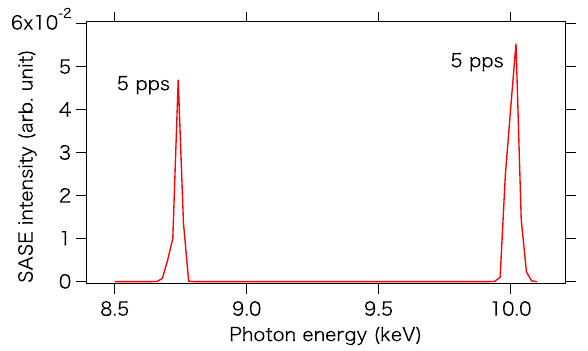
FIG. 5. Spectra of SASE measured by scanning a mono- chromator. The electron bunch repetition was 10 pps and the beam energy was alternately changed between 7.3 and 7.8 GeV.